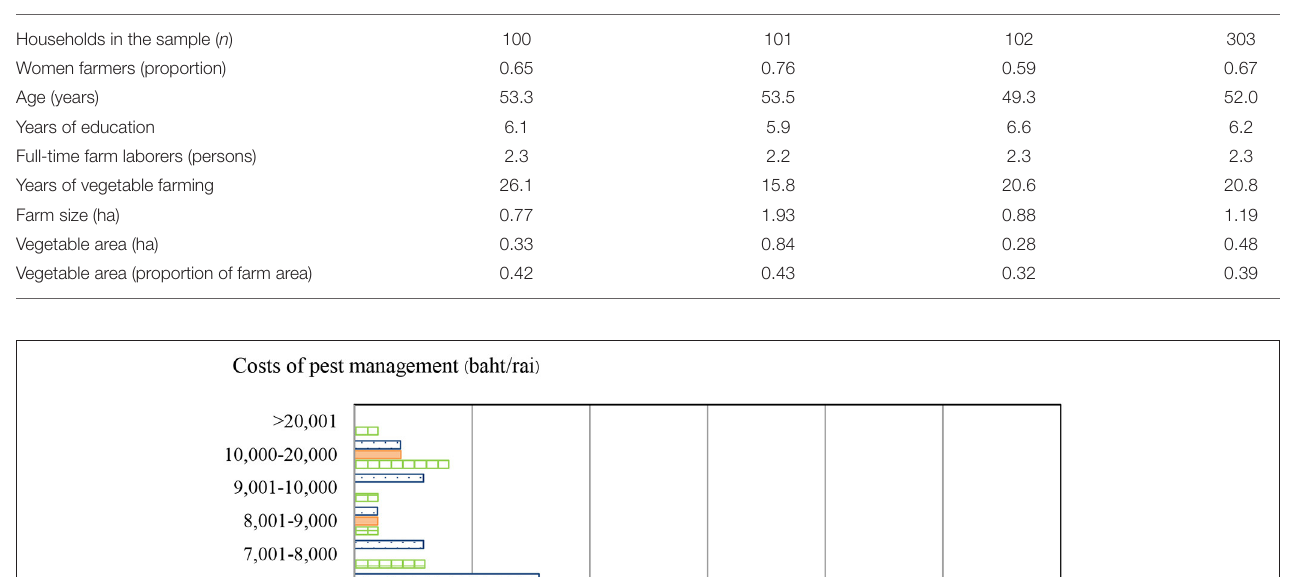
TABLE 3 | Average socio-economic characteristics of the sample of vegetable farmers, 2016. Characteristic Nakhon Pathom Pathum Thani Ratchaburi